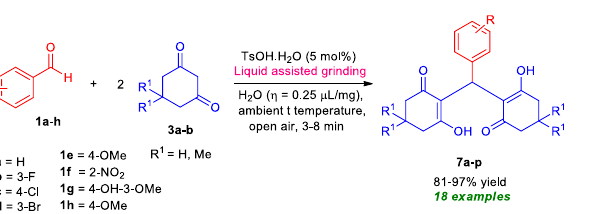
Figure 8. Synthesis of 2,2 ′ -aryl/heteroaryl-methylene-bis(3-hydroxy-cyclohex-2-enone) under the standard